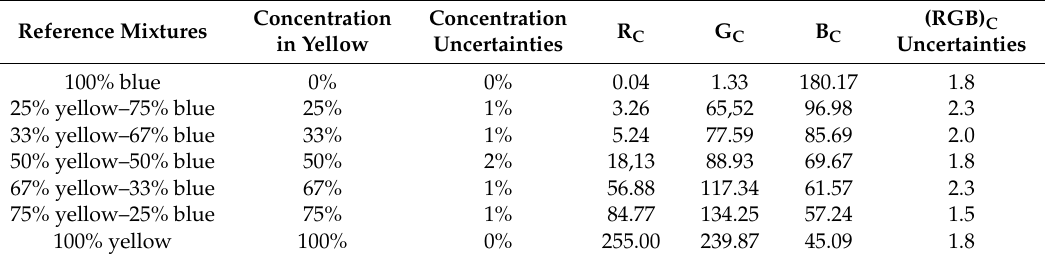
Figure A14. Constitution of a CaliPhoto database of painting mixtures. ( a ) Original photograph and reference image after CaliPhoto processing and ( b ) original photographs and processed images of reference mixtures. Table A7. CaliPhoto RGB values database for yellow / blue paint mixtures. Concentration uncertainties are a function of the syringe precision and the volumes used. R C , G C and B C are the CaliPhoto RGB values of the mixtures. Uncertainties on those values are given by 256 × Δ .